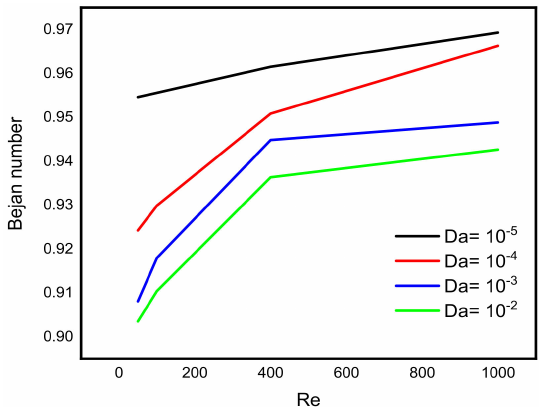
Figure 9. Variation in the Nusselt number with Reynold number at different levels of Darcy number.